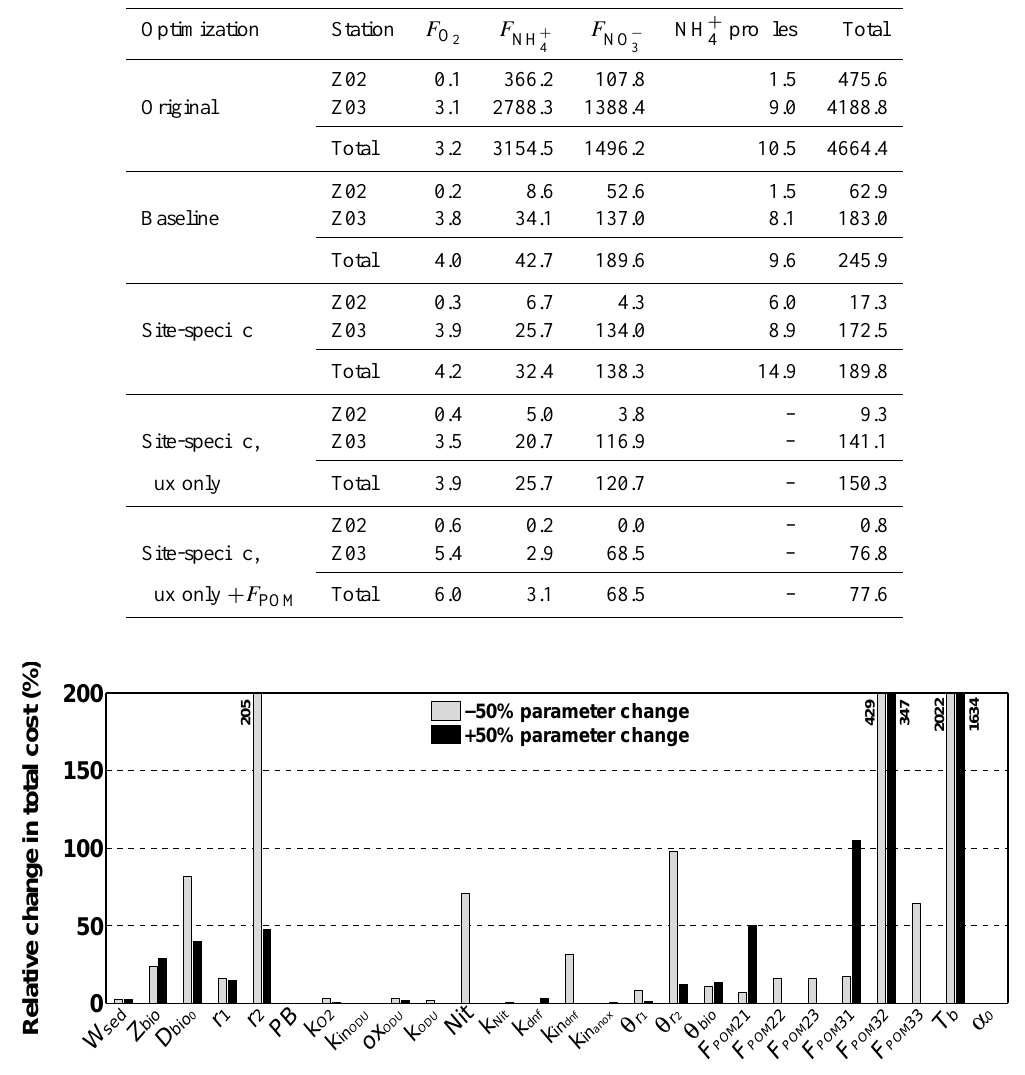
Figure 5. Sensitivity of model results to parameter